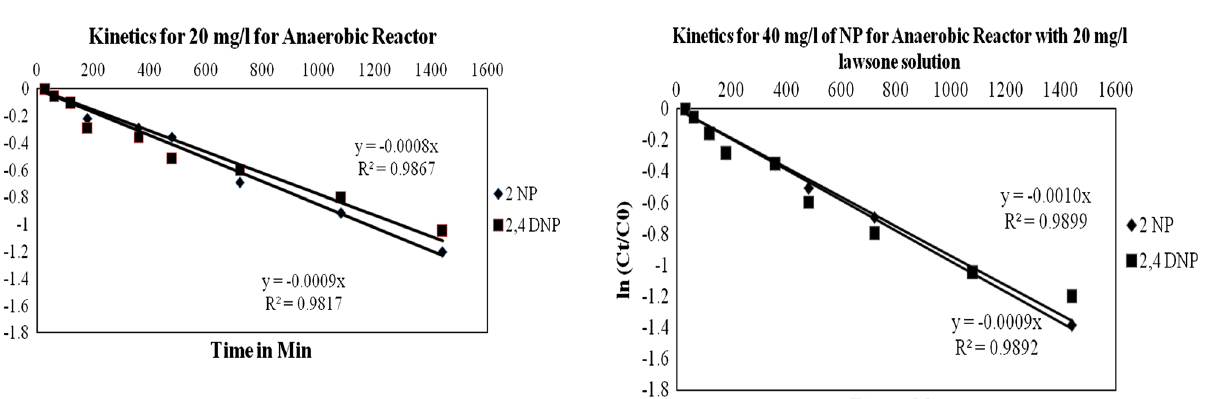
Fig. 12 Kinetics for 20 mg/l nitrophenol loading